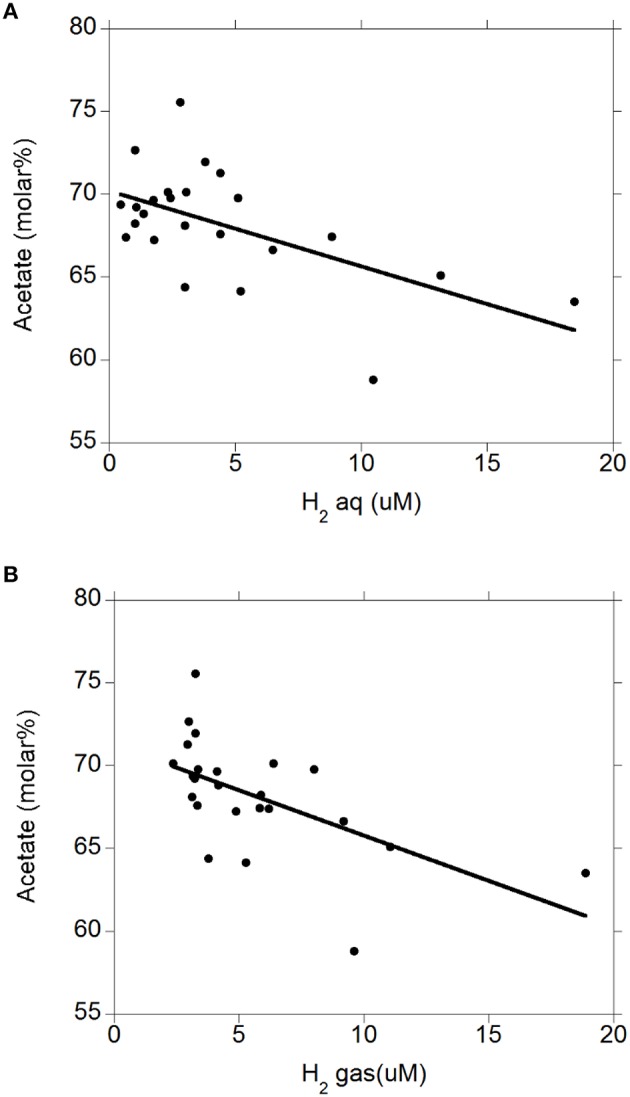
Relationship between acetate molar percentage and concentration of dissolved and gaseous H2. (A) acetate% = 70.2 (±0.84; P < 0.001) − 0.45 (±0.14; P = 0.003) H2 (aq); R2 = 0.34 (P = 0.003); (B) acetate% = 71.3 (±1.07; P < 0.001) − 0.55 (±0.16; P = 0.003) H2 (g); R2 = 0.36 (P = 0.003).